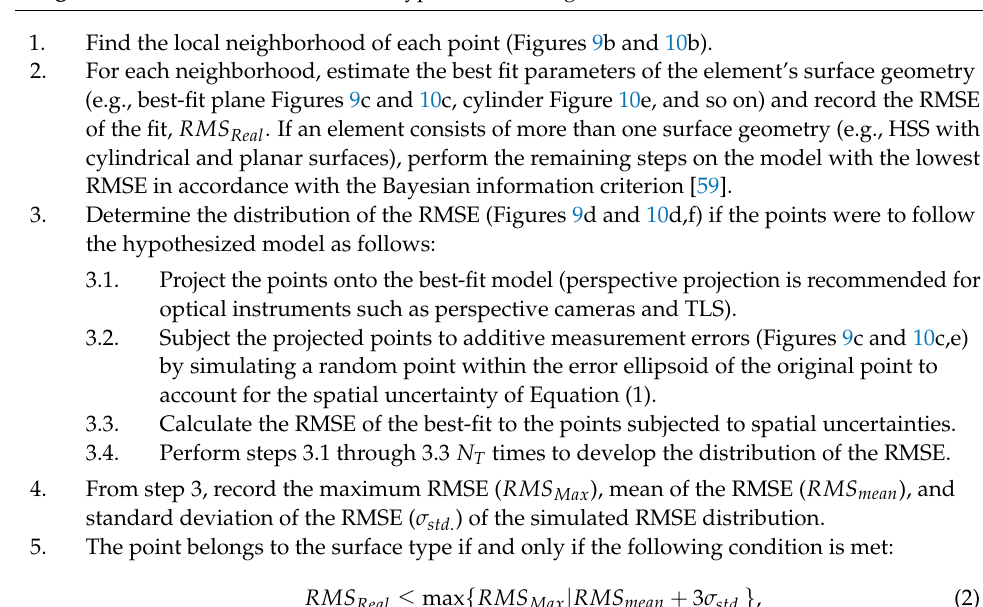
Algorithm 2 Point-Cloud-to-Model Hypothesis Testing.